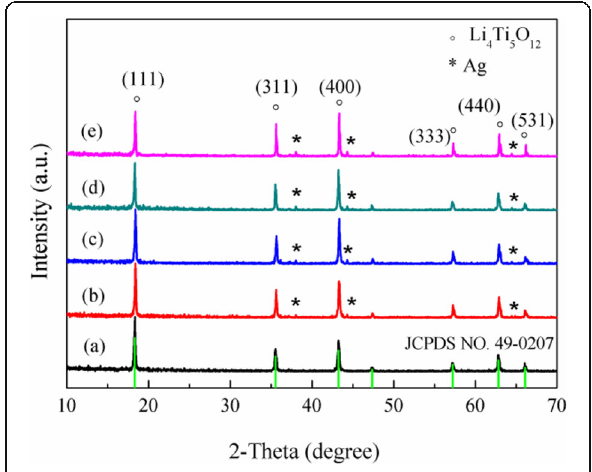
Fig. 1 XRD patterns of the Li 4 Ti 5 O 12 /Ag. ( a ) 0 wt.%, ( b ) 1 wt.%, ( c ) 3 wt.%, ( d ) 5 wt.%, and ( e ) 7 wt.%